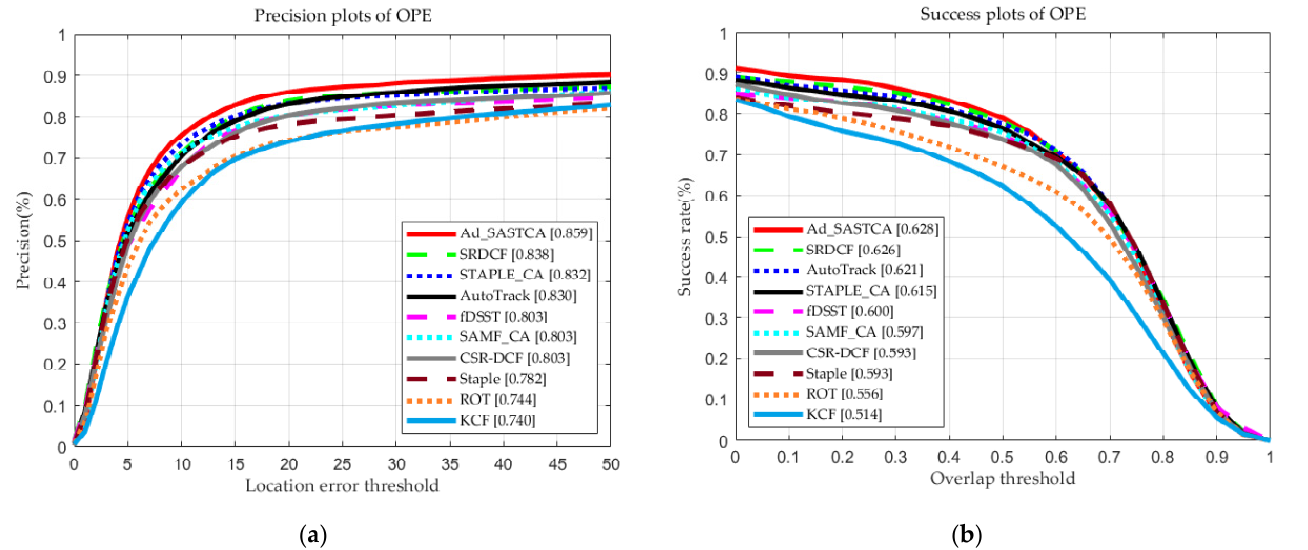
Figure 3. Overall experimental results of precision plot ( a ) and success plot ( b ) comparing Ad_SASTCA with nine state-of the art trackers on OTB-2013. The trackers in figures ( a ) and ( b ) are sorted according to precision and AUCs, respectively. Best viewed in color and high resolution.